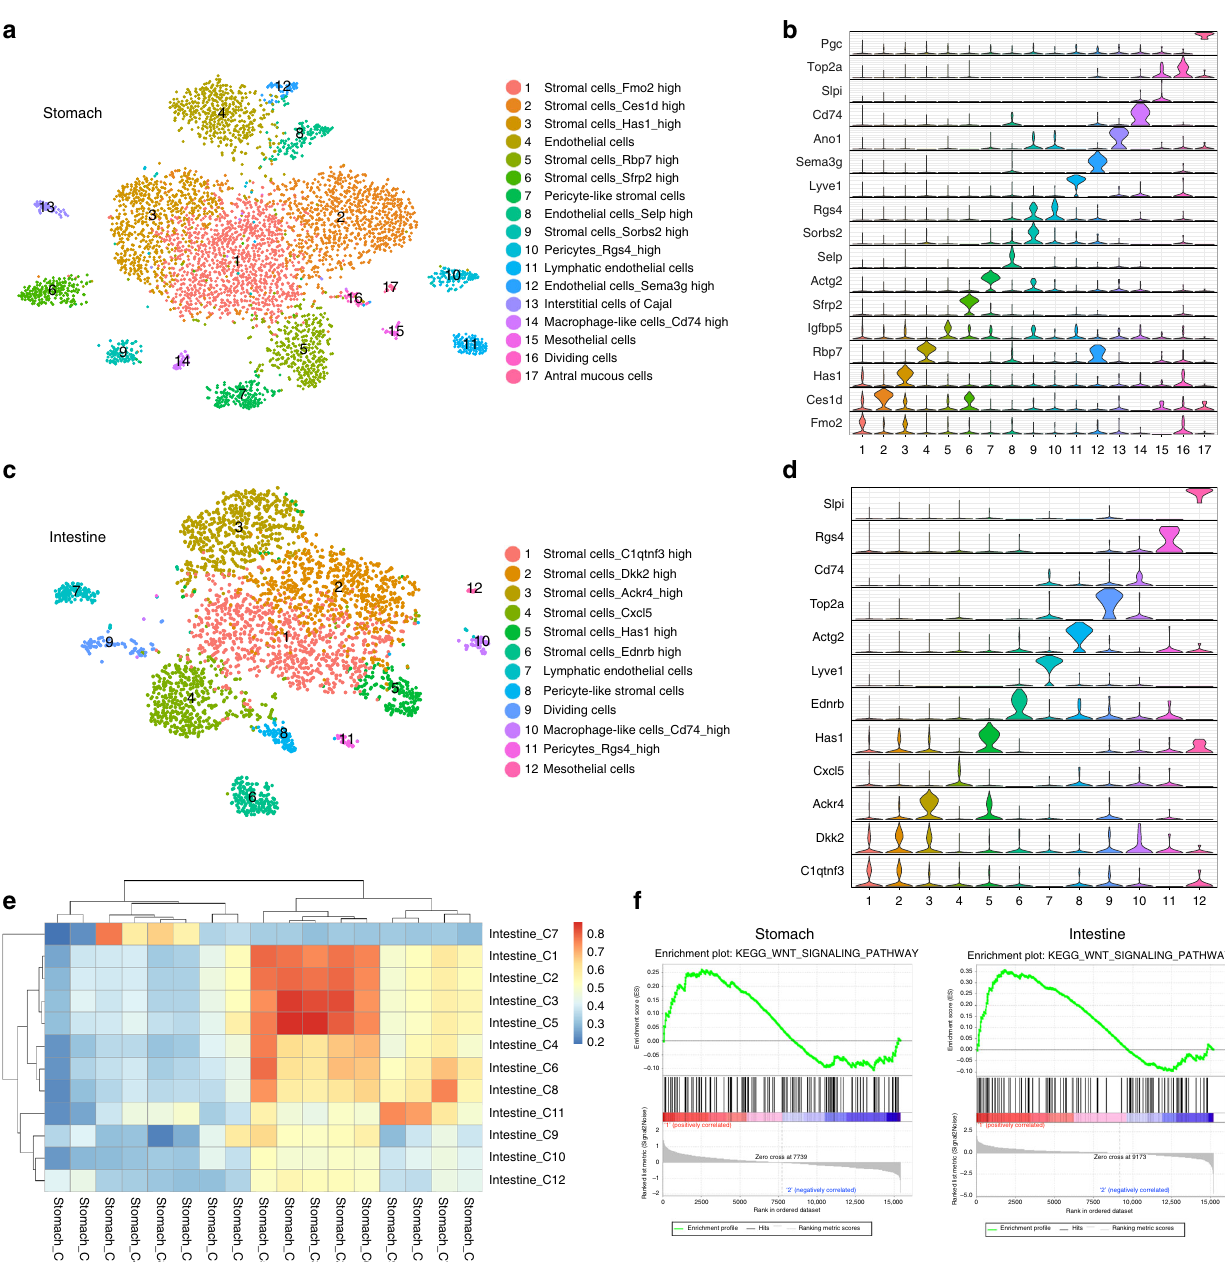
Fig. 1 Identi fi cation of conserved stromal cell populations between the stomach ad intestine. a , c t-SNE plots identify 17 different clusters in 4946 stomach cells ( a ) and 12 different clusters in 3459 intestinal cells ( c ). Cells from two mice were pulled for stomach ( a ) and intestinal ( c ) single cell RNA-seq. b , d Violin plots show expression levels of represented markers within each cluster in the stomach ( b ) and intestine ( d ). e Unsupervised hierarchical clustering shows gene expression correlation between the stomach and intestinal stromal cell clusters. A correlation of 0.7 was used to de fi ne stromal cell populations conserved between the stomach and intestine. f , g The gene set enrichment analysis (GSEA) shows enrichment of the WNT signaling pathway in conserved populations compared to distinct